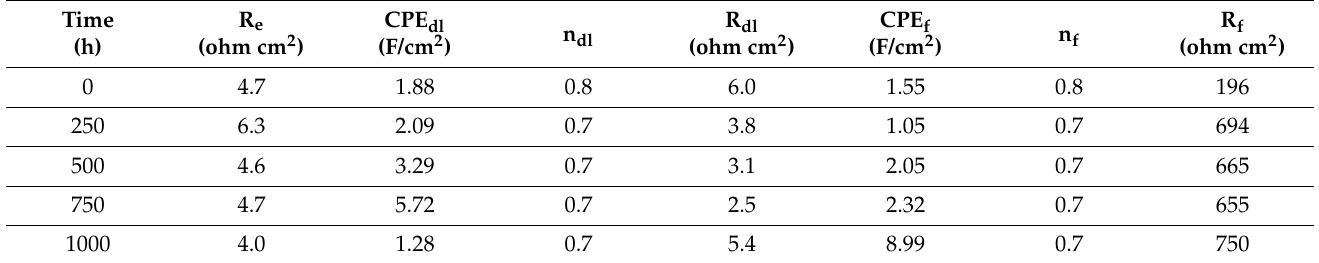
Table 4. Electrochemical parameters obtained from the fitting of the EIS data at 500 ◦